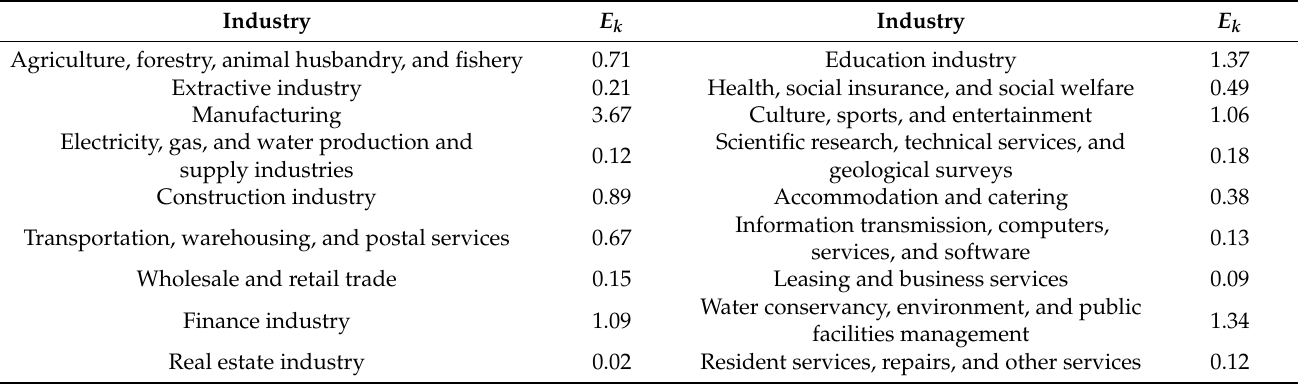
Table 3. Urban agglomeration total export capacity by industry.